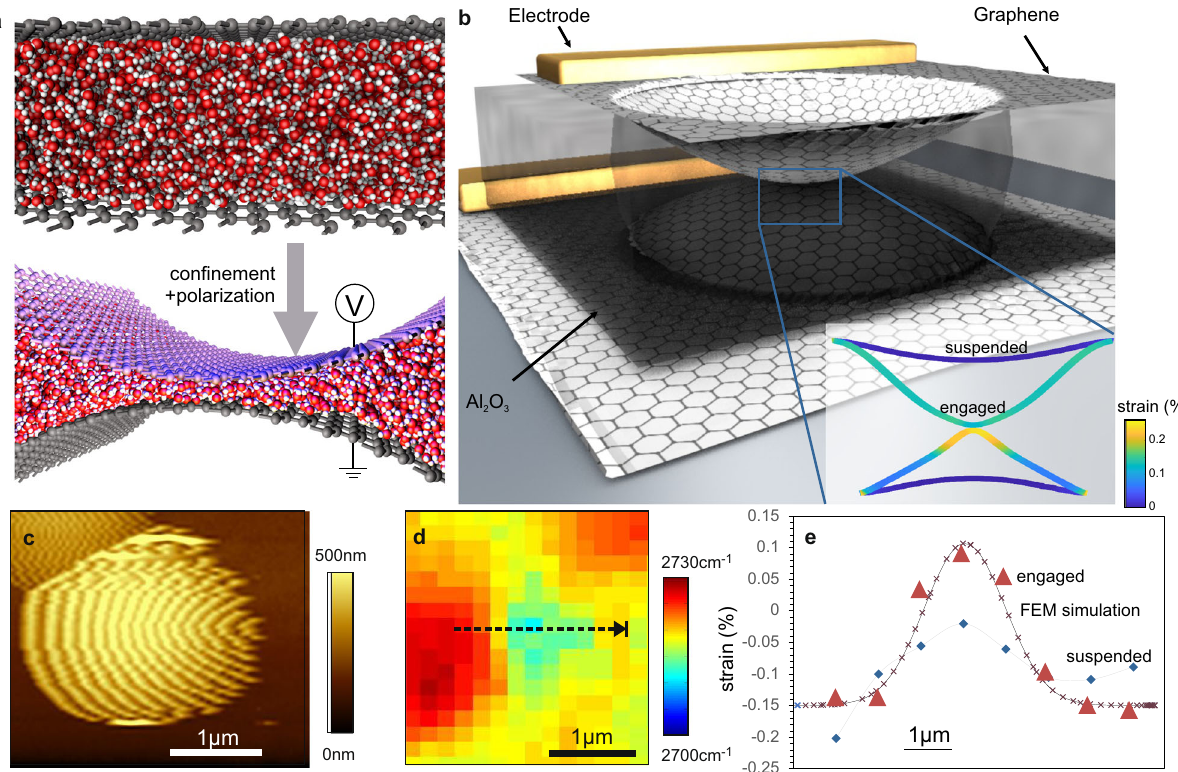
Fig. 1 Nanoelectromechanical actuation scheme. ( a ) concept of nanoelectromechanical con fi nement of water between graphene, ( b ) schematic of employed device structure, (Inset) fi nite-element simulation of deformation and strain distribution upon contact ( c ) tapping mode AFM image of suspended top layer over drum structure, ( d ) map of Raman 2D band position, ( e ) strain distribution extracted from Raman scaling analysis corresponding to the cross-section in ( d ).